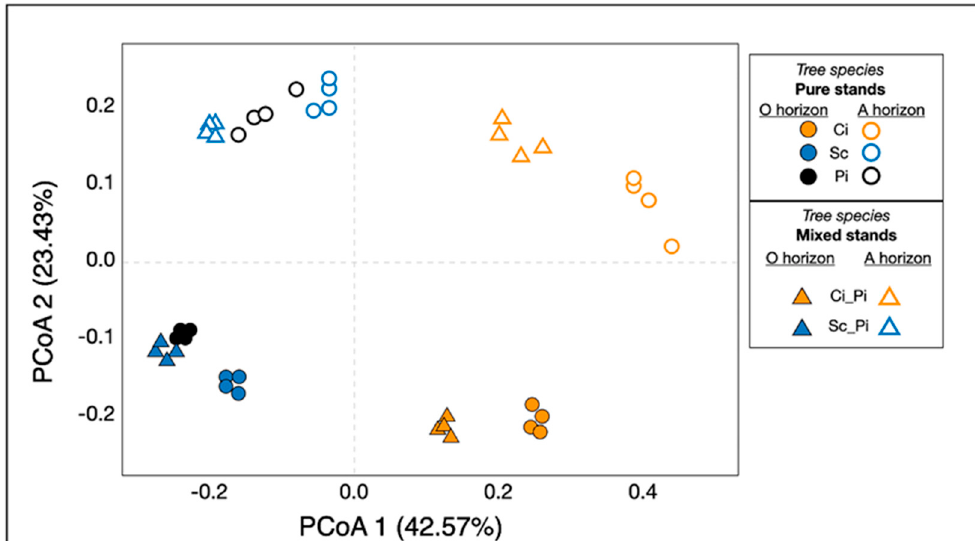
Figure 3. Principal coordinates analysis of soil bacterial communities. Samples of pure stands are shown with circular shapes, while mixed stands are shown with triangles. The shape color corresponds to tree species: pure stands of Ci and mixed stands of Ci are both shown as orange shapes; pure stands of Sc and mixed stands of Sc are both shown as blue shapes; pure stands of Pi are indicated by black shapes only. Closed shapes, filled in with the corresponding color, are shown to indicate soil from O horizons; samples shown with open shapes, with colored outlines and white space within, indicate samples from A horizons.